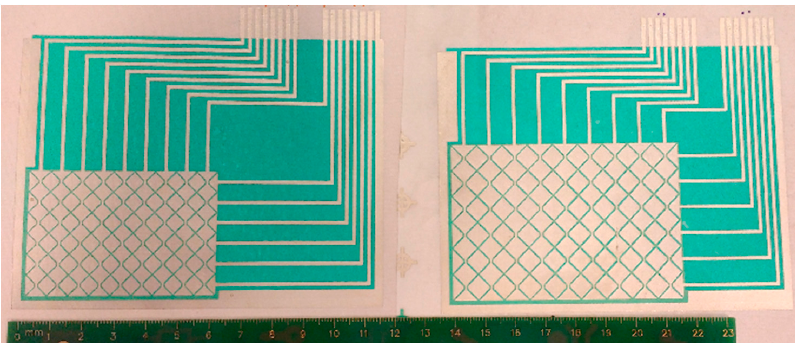
Figure 11. Touchpads with the same design but different size.